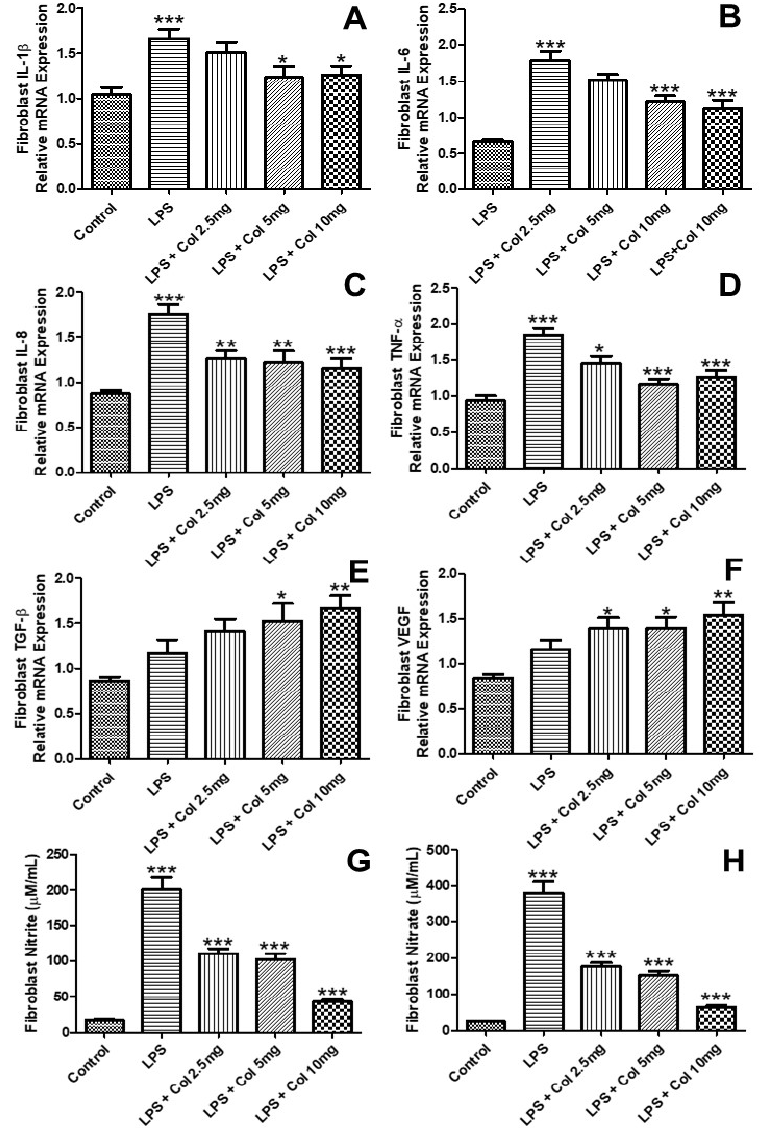
Figure 5. The effects of collagen supplementation on the levels of IL-1 β ( A ), IL-6 ( B ), IL-8 ( C ), TNF- α ( D ), TGF- β ( E ), VEGF ( F ), nitrite ( G ), and nitrate ( H ) of human keratinocytes. For ( A ), *** p < 0.001 compared with the control group and LPS group and * p < 0.05 compared with the LPS group. For ( B ), *** p < 0.001 compared with the control and LPS groups. For ( C ), *** p < 0.001 compared with the control and LPS groups and ** p < 0.01 compared with the LPS group. For ( D ), *** p < 0.001 compared with the control and LPS group and * p < 0.05 compared with the LPS group. For ( E , F ), ** p < 0.01 compared with the LPS groups and * p < 0.05 compared with the LPS group. For ( G , H ), *** p < 0.001 compared with the control and LPS